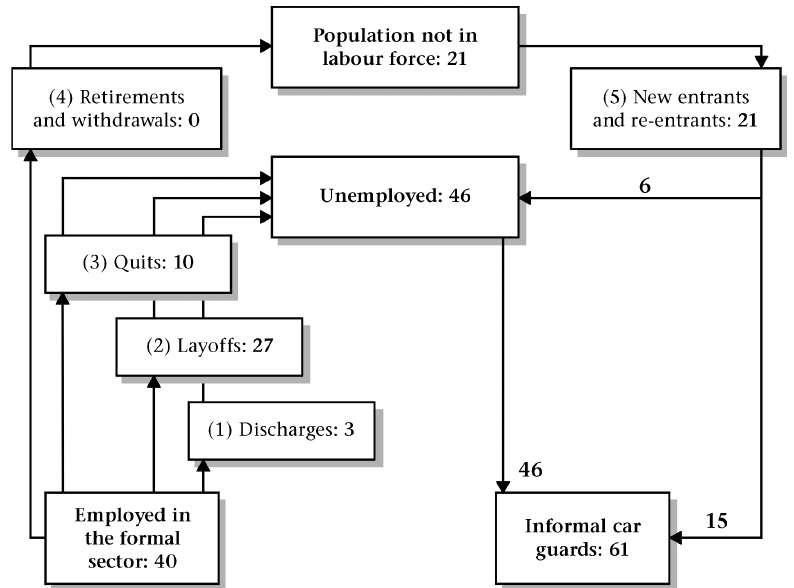
Figure 2: The stock-flow model – informal car